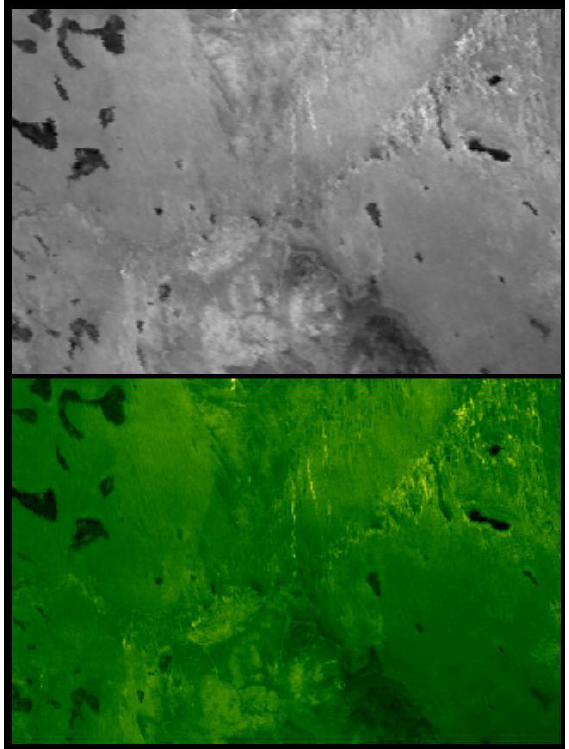
Figure 10 indicated that the residuals are not random with respect to the derived height-to-width